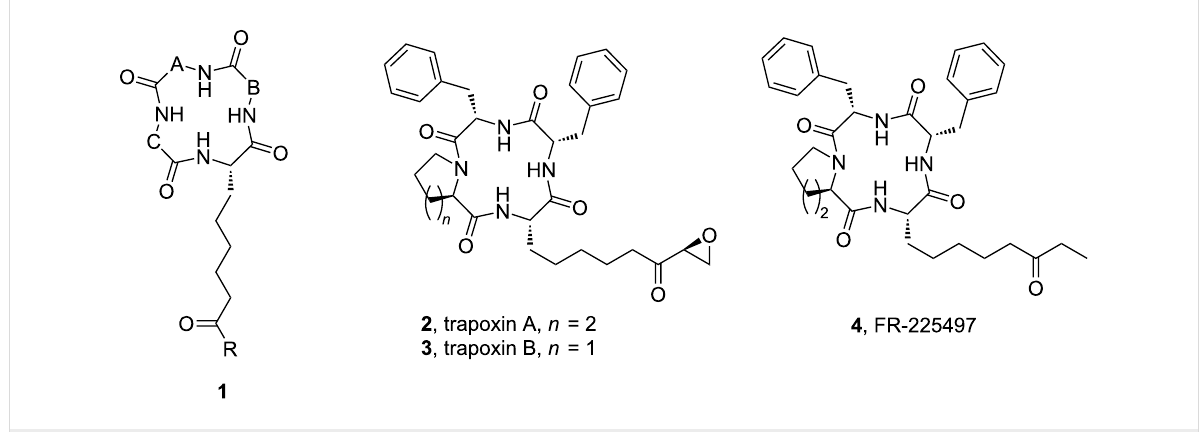
Figure 1: Structure of FR-225497 ( 4 ) and related cyclic tetrapeptides.